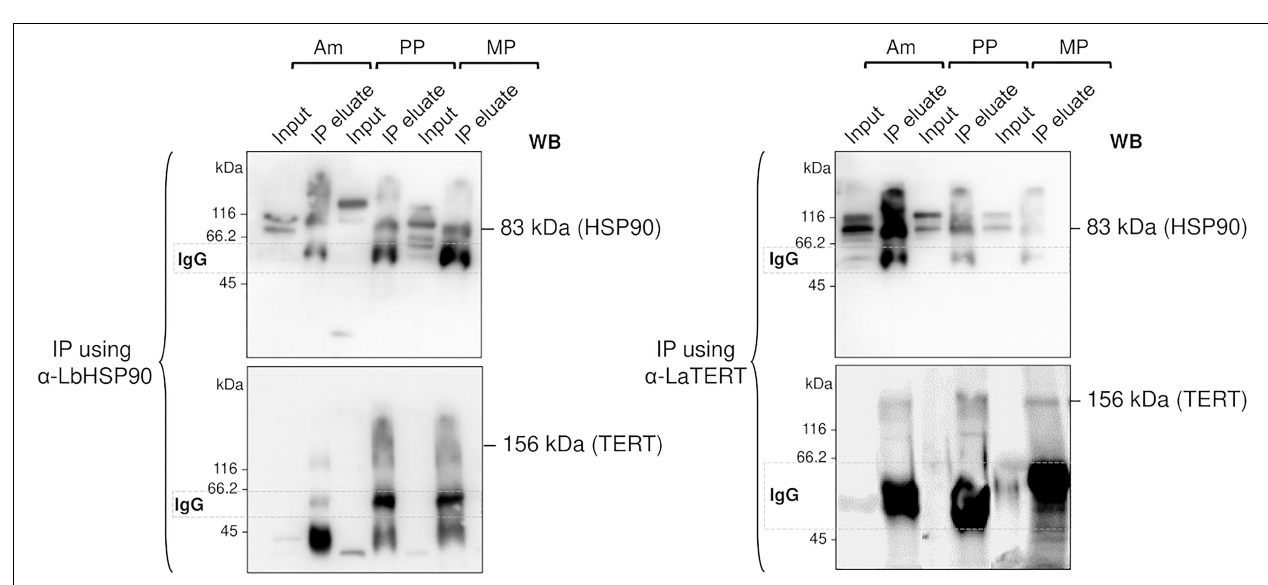
FIGURE 4 | LHSP90 and the telomerase TERT component co-immunoprecipitated in the three L. amazonensis life forms. Co-immunoprecipitation (IP) assays were done using DynaBeads protein A, 20 µ g of each telomerase positive extracts (input) obtained from Am, PP and MP, and specific polyclonal sera against LbHSP90 (left) or LaTERT (right). The total amount of IP eluates and 20 µ g of each protein extracts (used as input) were fractionated in 10% SDS-PAGE and submitted to western blot analysis revealed with anti-LaTERT and anti-LbHSP90 sera. Goat anti-rabbit HRP-conjugate was used as the secondary antibody (Bio-Rad). The results were detected using enhanced chemiluminescence (ECL), according to the manufacturer’s